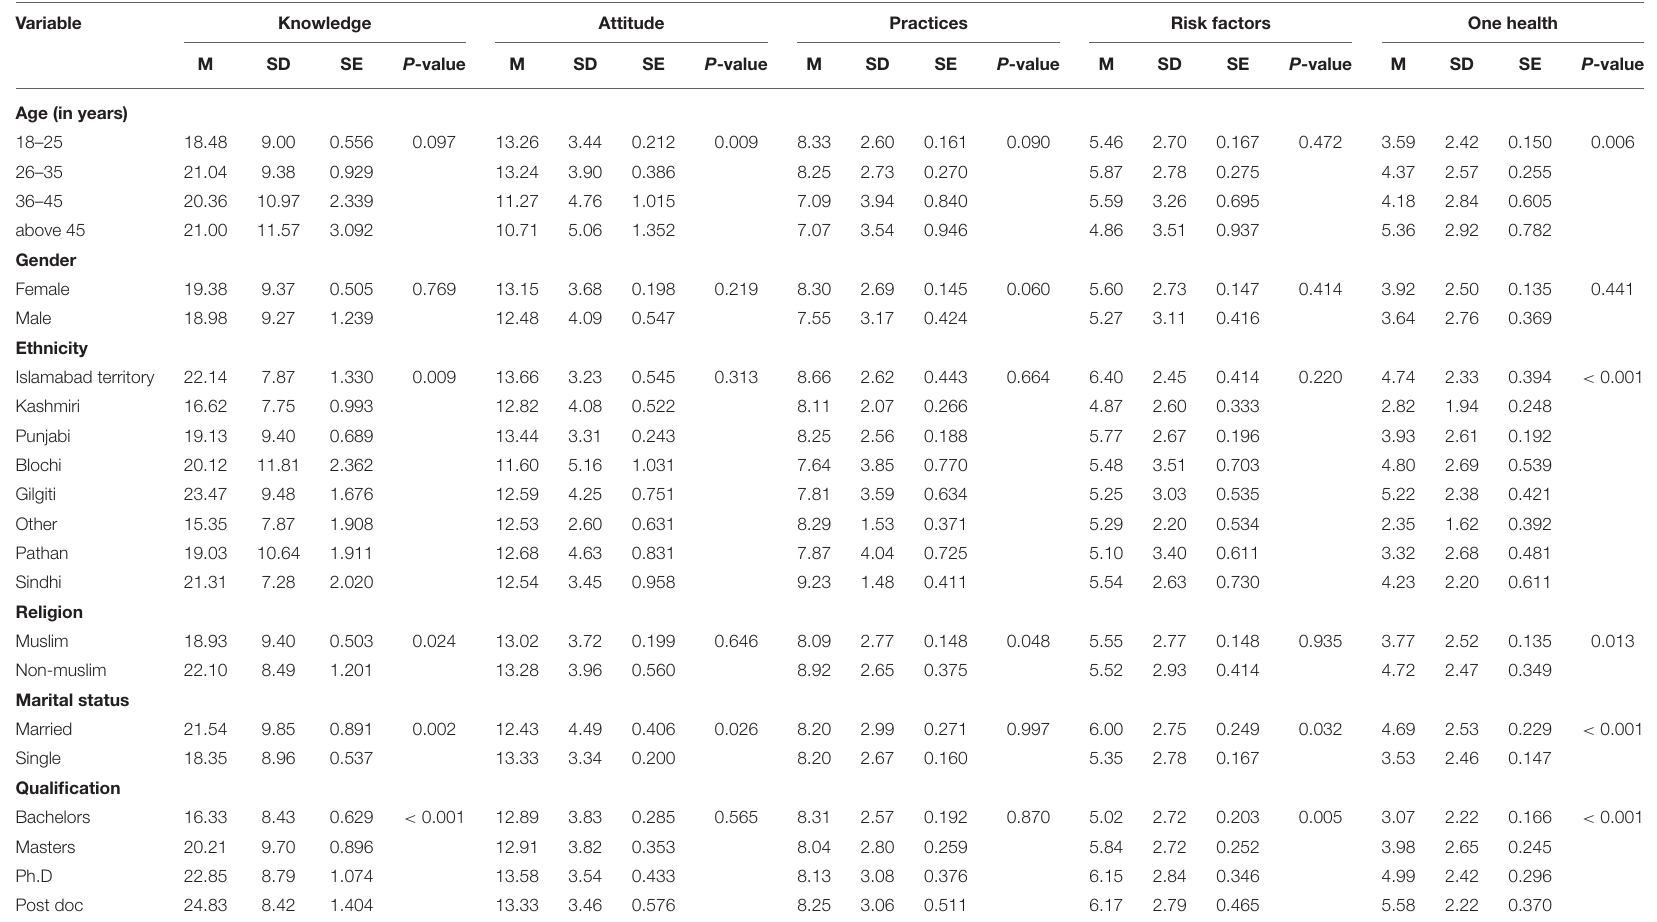
TABLE 7 | Association between demographic characteristics and knowledge, attitude, practices, one health, and risk factors (ANOVA). Variable Knowledge Attitude Practices Risk